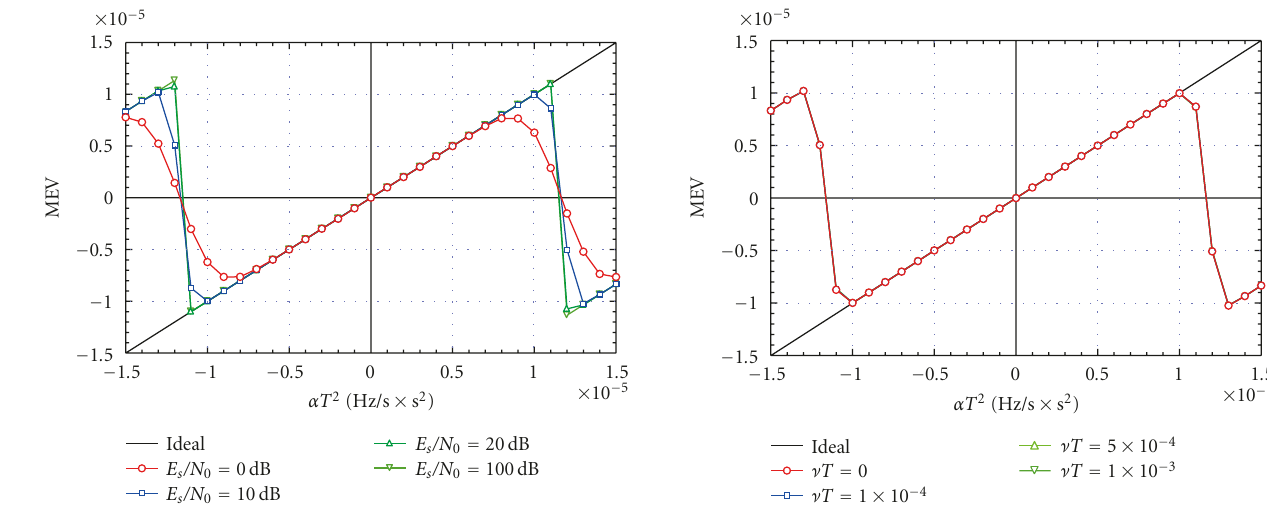
Figure 11: MEV of FRE-3PE estimator for di ff erent values of the Doppler-shift vT —simulation only. 3 blocks of pilots, N = 45, M = 384, E S /N 0 = 10